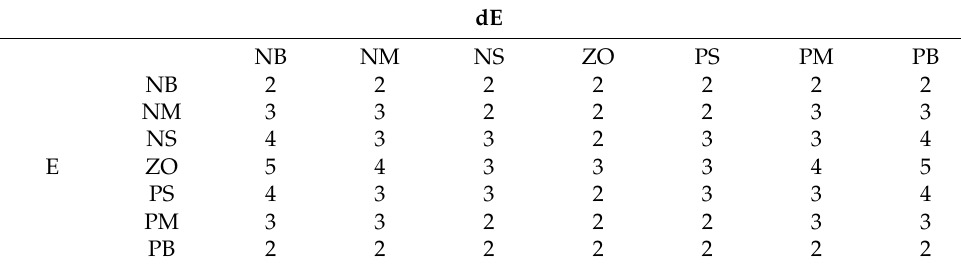
Table 3. Fuzzy tunning rules for α